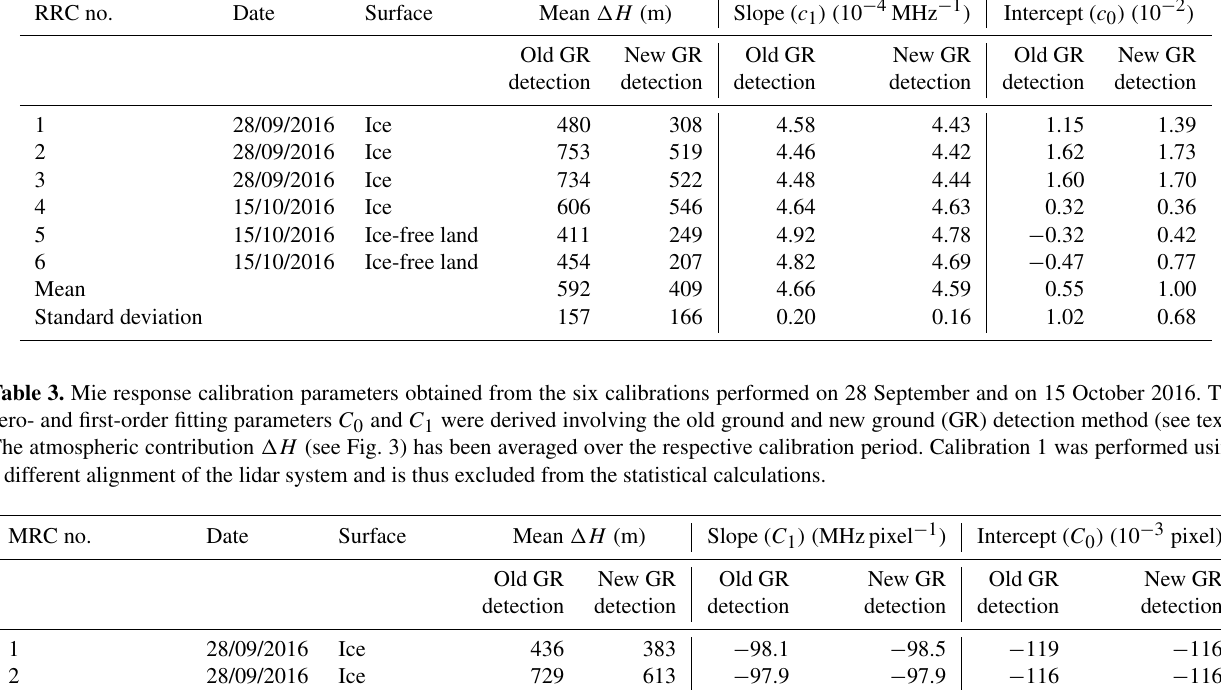
Table 2. Rayleigh response calibration parameters obtained from the six calibrations performed on 28 September and on 15 October 2016. The zero- and first-order fitting parameters c 0 and c 1 were derived involving the old ground and new ground (GR) detection method (see text). The atmospheric contribution (cid:49)H (see Fig. 3) has been averaged over the respective calibration period. Calibration 1 was performed using a different alignment of the lidar system and is thus excluded from the statistical calculations. RRC no.